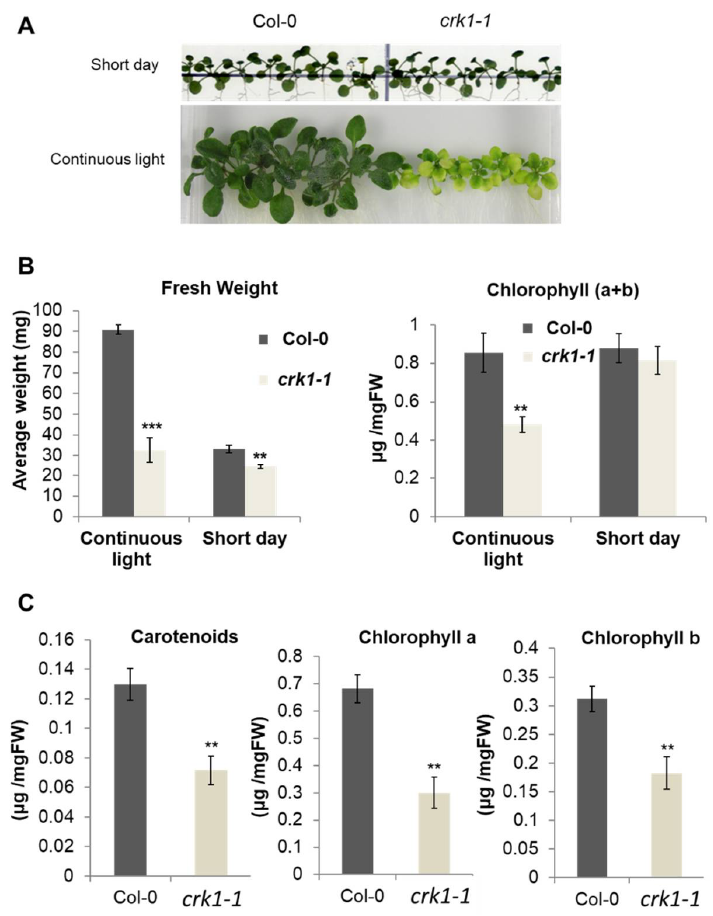
Figure 6. Light sensitivity of the At crk1-1 mutant plants . ( A ) Images of 3-week old wild type (Col-0) and mutant ( crk1-1 ) plantlets grown on vertical plates under continuous light or short day illumination; ( B ) Fresh weight and chlorophyll a+b contents of 3-week old plantlets under continuous light and short day conditions; ( C ) Carotenoid, chlorophyll a, chlorophyll b contents of 3-week old plantlets under continuous light. Values are means ± SD, n = 15 seedlings. Statistically significant values were calculated by Student’s t test for ** p < 0.005 and *** p < 0.0005 .